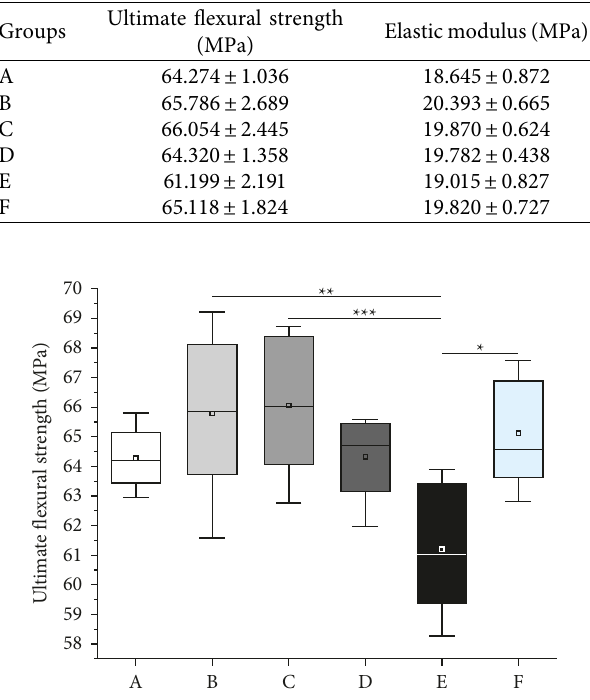
Figure 3: Ultimate flexural strength of resins having different values.